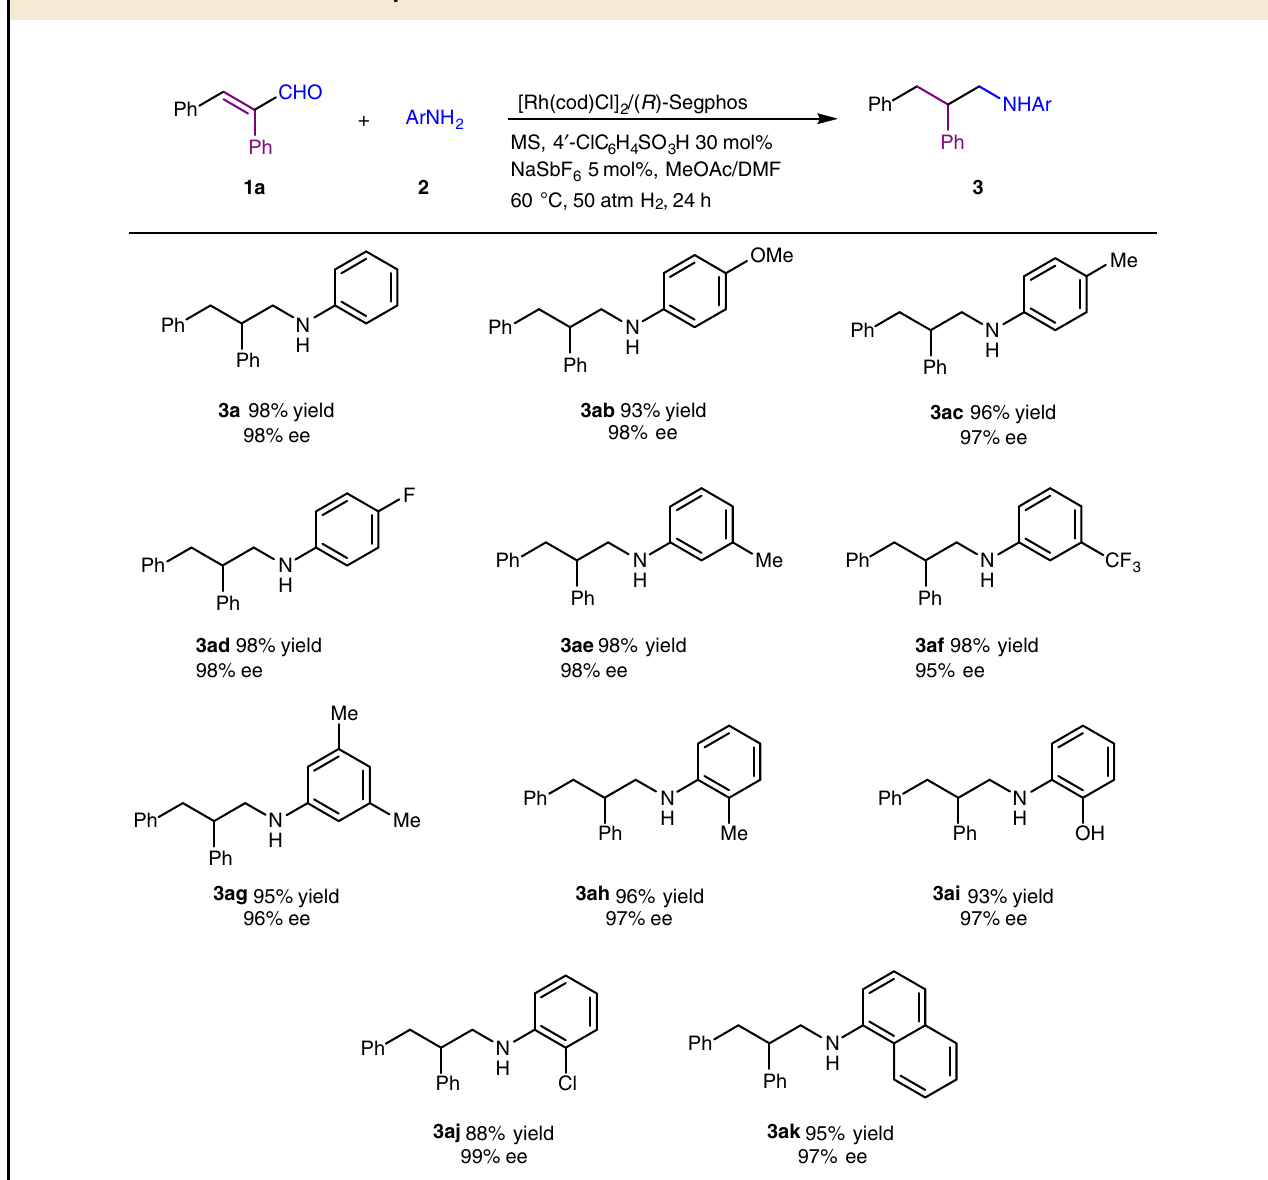
Table 3 Examination of the aniline scope.